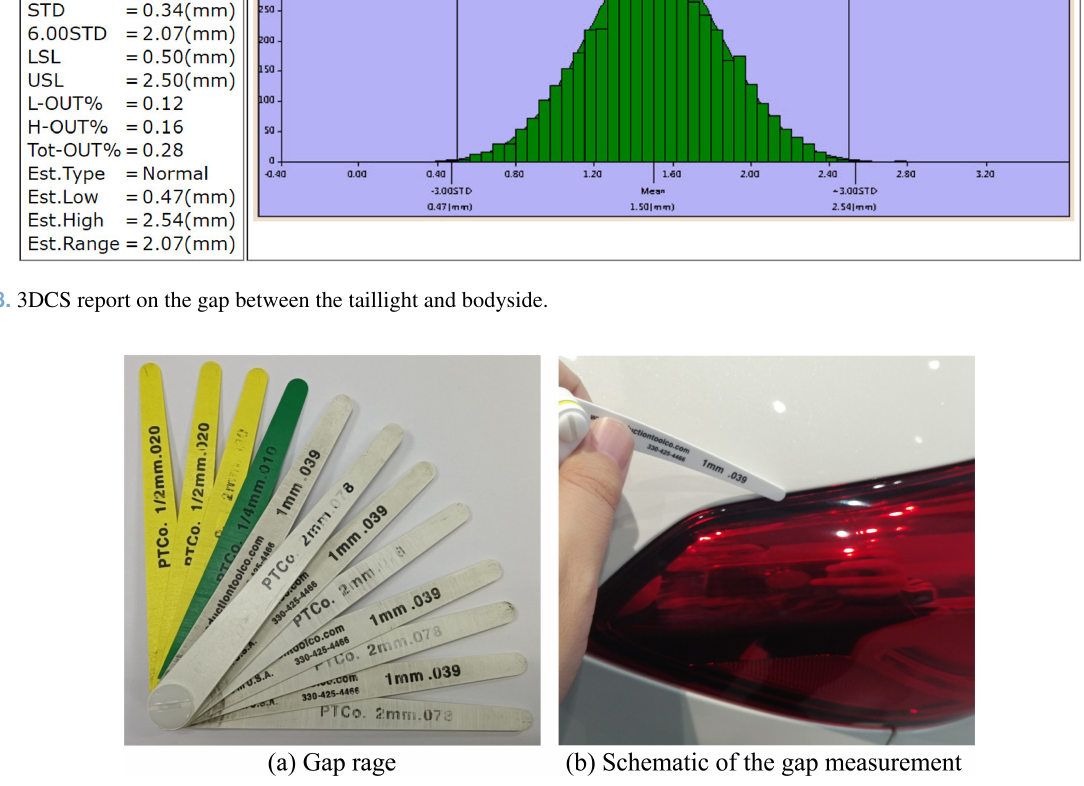
Figure 9. Gap gauge and the schematic of the gap measurement.